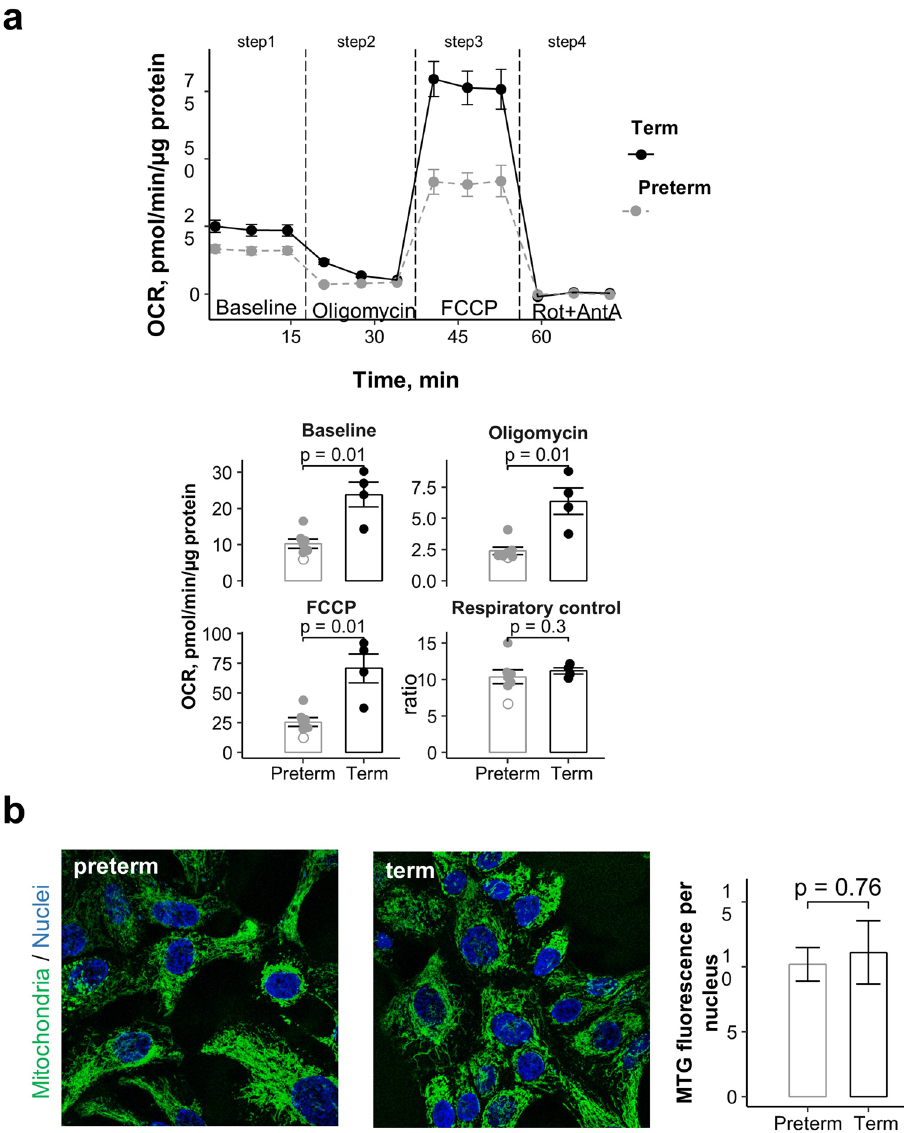
Figure 4. Diminished mitochondrial activity in preterm NP-derived basal cells. ( a ) Seahorse analysis of cellular oxygen consumption rate (OCR) over time in cultured NP-derived basal cells from preterm and term subjects; effects of selected compounds on different steps of the mitochondrial respiratory chain. OCR quantification at Baseline, Oligomycin-treatment, FCCP treatment and the cellular respiratory control ratio calculated as a ratio of the FCCP rate to Oligomycin rate. Each point represents an individual infant (n = 4 for term infants and n = 7 for premature infants). Open circle marks the premature infant with the youngest gestational age in the study (25 weeks gestational age). Bar graphs are mean ± SEM; p-values of the Mann–Whitney U test are shown. ( b ) MitoTracker Green (MTG) FM fluorescence staining in preterm and term confluent basal cells in culture (DAPI, blue). Graphs: bars are mean (± SEM) of MTG per nucleus in preterm and term cells; p-value (depicted) Student t